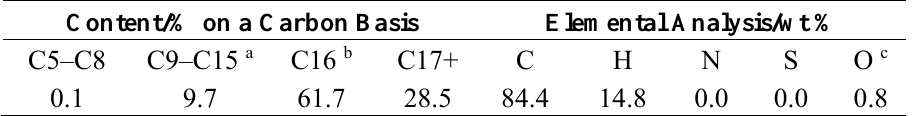
Table 3. Analyses of the FT product as a feedstock of hydrocracking.